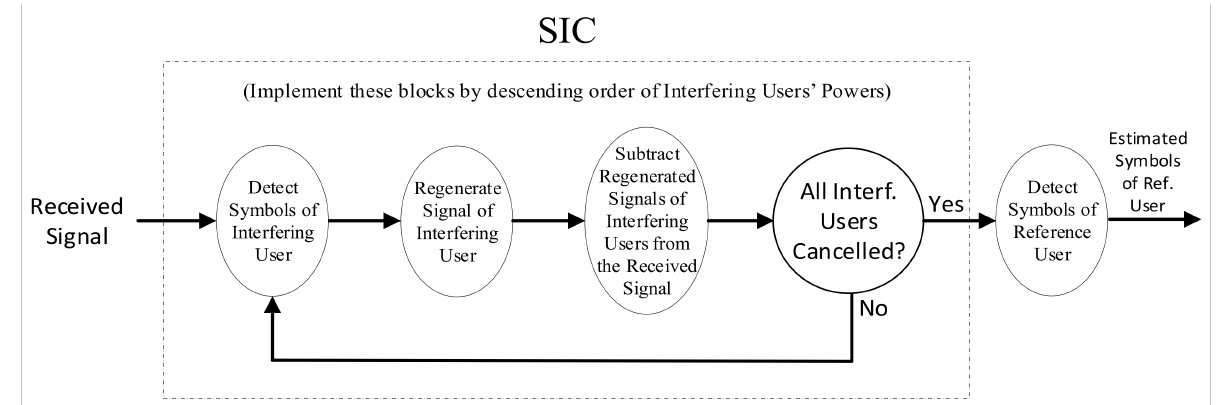
Figure 3. Conventional NOMA and its detection using